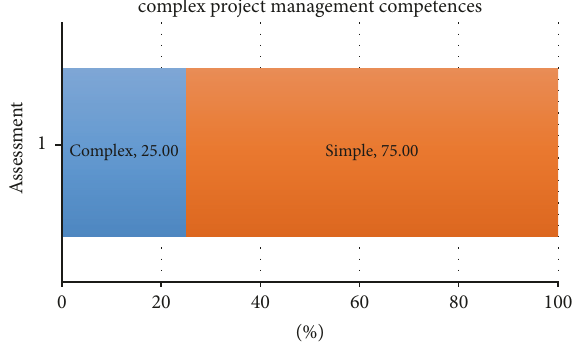
Figure 6: Complexity Index tool assessment result